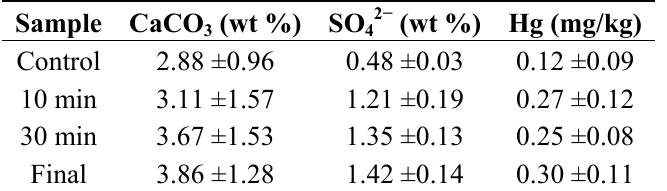
Table 3. CaCO (wt %), SO (wt %), and Hg (mg/kg) content of JBPP control and AMC 3 4 fly ash